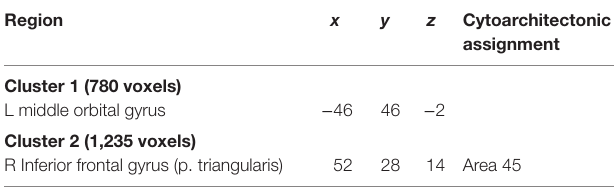
TaBle 2 | converging connectivity of the iFs seed. region x y z cytoarchitectonic